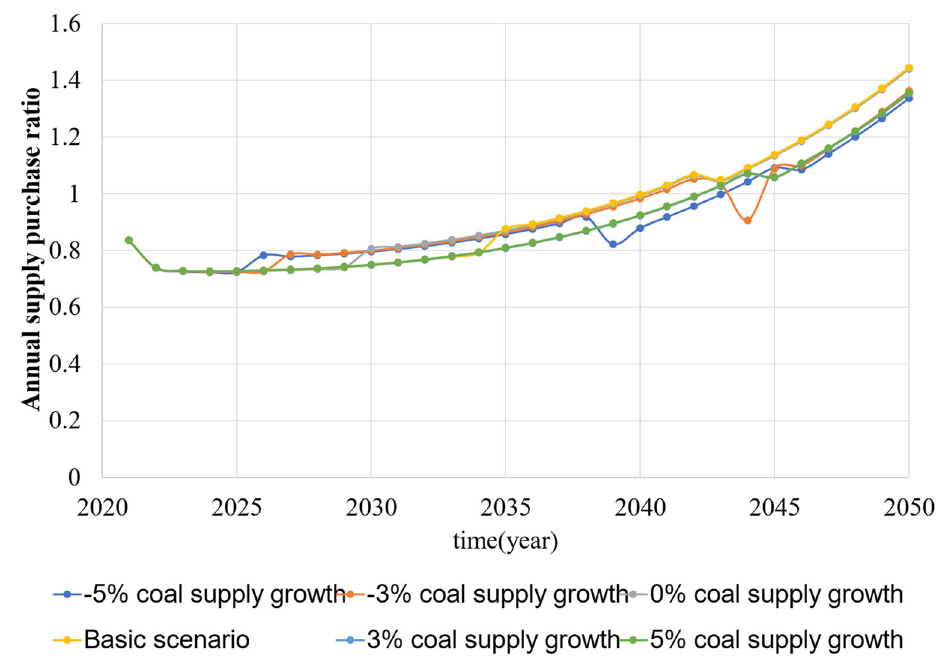
Figure 7. Change in annual supply–purchase ratio based on coal supply growth rate.